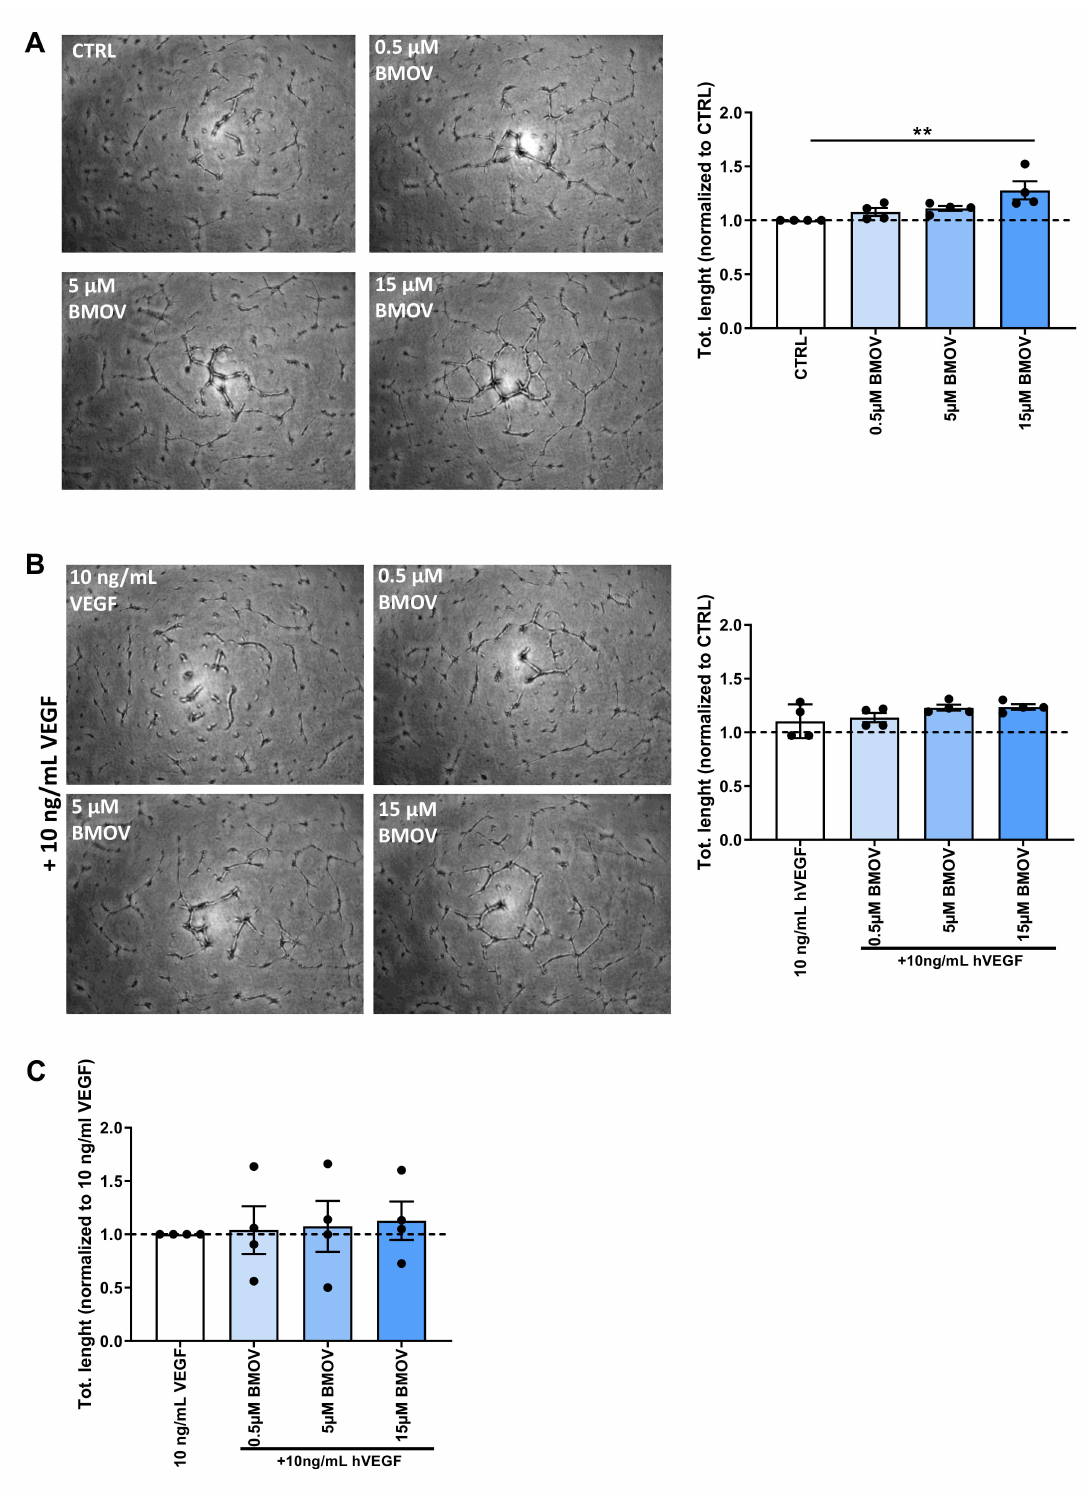
Figure 6. Representative images and quantification of HUVECs tube formation after treatment with either ( A ) BMOV alone in di ff erent concentrations (0.5, 5, 15 µ M) or ( B ) di ff erent concentrations of BMOV (0.5, 5, 15 µ M) supplemented with 10 ng / mL VEGF-A. ( C ) E ff ect of BMOV in the cell culture supplemented with 10 ng / mL VEGF-A. Datapoints represent averages obtained from 3 independent experiments and are presented as mean ± SEM. ** p < 0.01 by One-Way